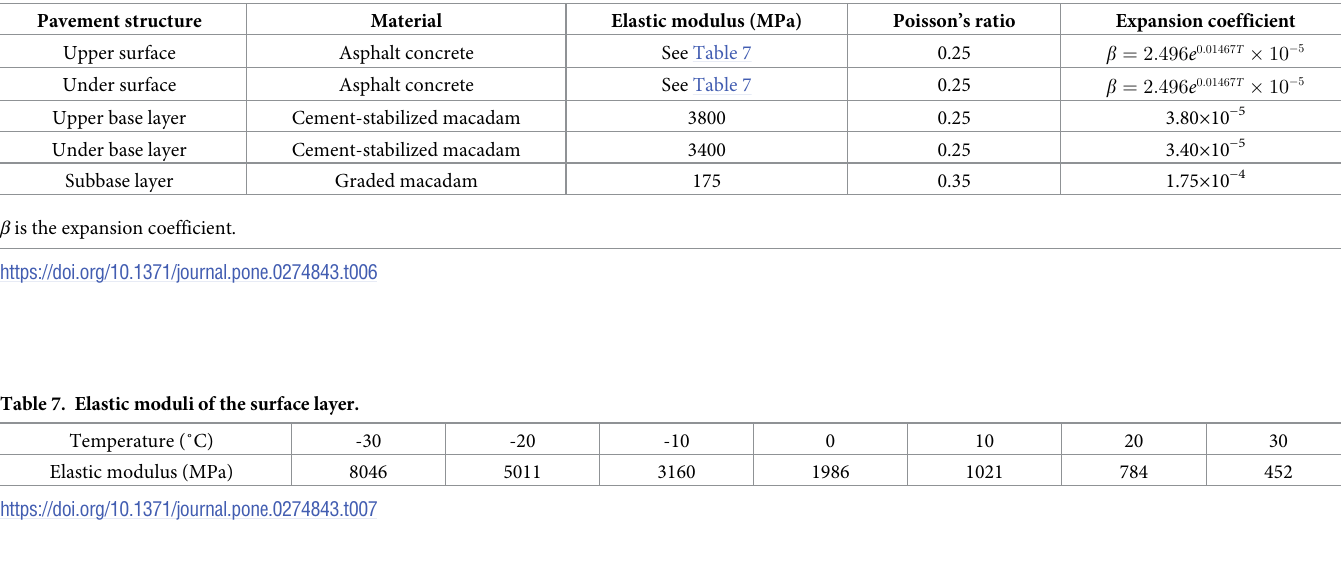
Table 6. Mechanical parameters of pavement structure layers.